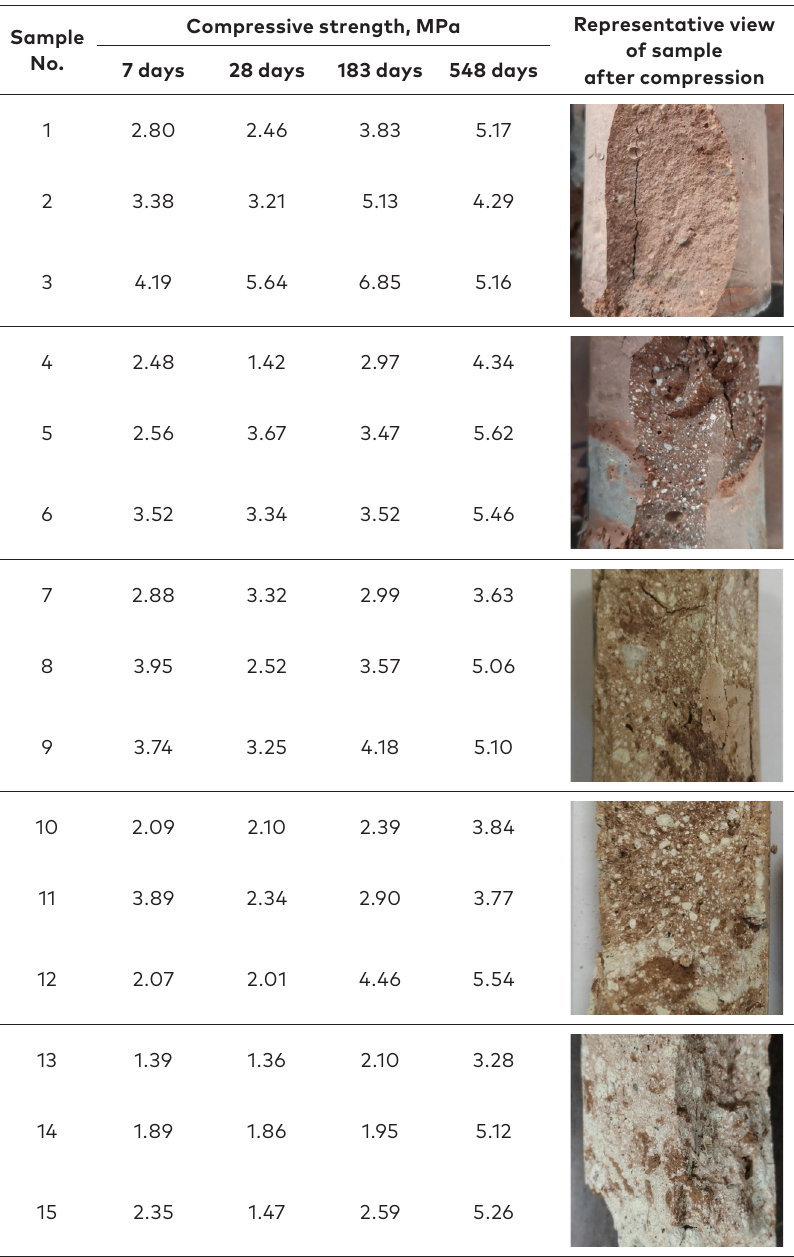
Table 3. Updated compressive strength of investigated samples after* Sample No.